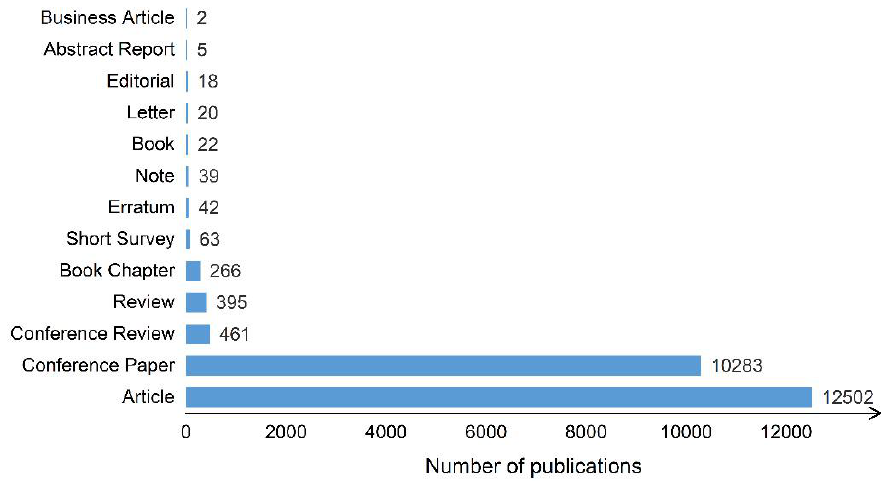
Figure 2. Number of different types of publications on LiDAR (2000–2016). (Source: Scopus database).